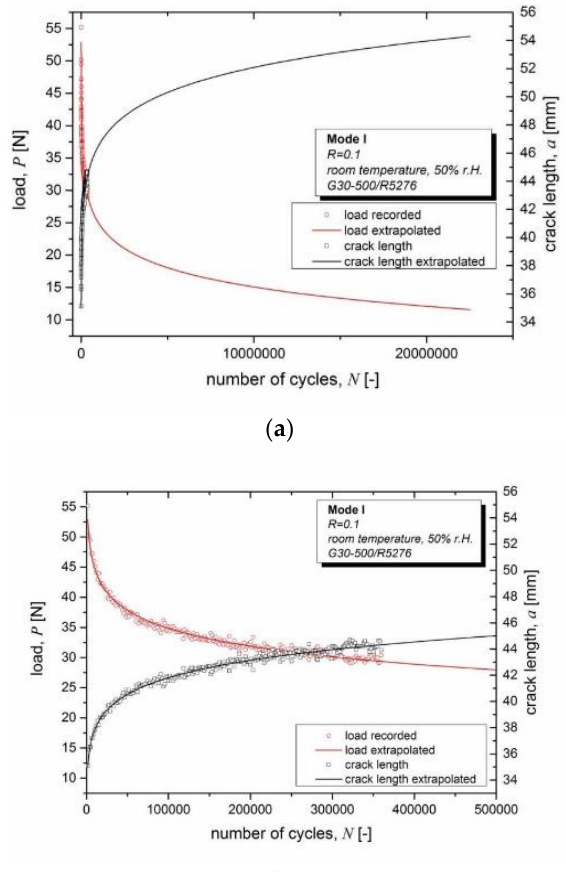
Figure 7. An example of a long-term extrapolation from fitting measured load and crack length data of a Mode I fatigue fracture test, ( a ) full extrapolation, ( b ) showing measured data and extrapolation up to 500,000 cycles.